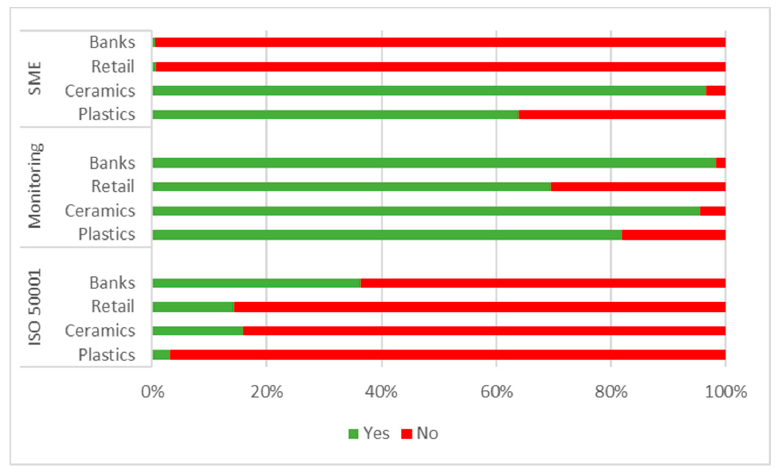
Figure 2. Share of the total final energy consumption by category.